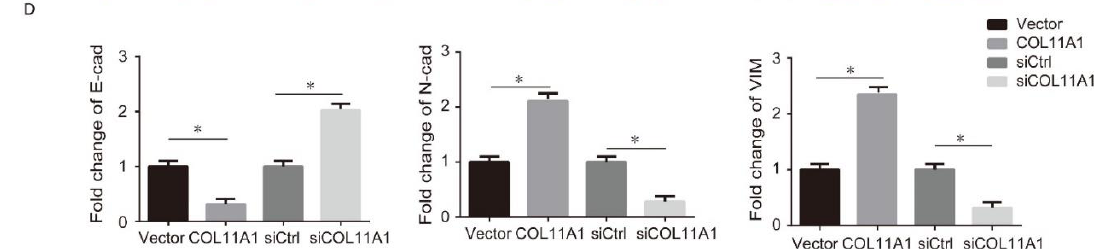
Figure 2. COL11A1 modulated the expression levels of epithelial-mesenchymal transition (EMT) markers and matrix metalloproteinase (MMP)-2/9: ( A ) expression levels of EMT markers and MMP- 2/9 were detected by Western blotting analysis in BxPC-3, Capan-2, and PANC-1 cells transfected with siCOL11A1 or pCMV3-COL11A1; ( B ) protein levels of EMT markers and MMP-2/9 were normalized to those of β -actin in PANC-1, BxPC-3, and Capan-2 cells after the indicated treatment; ( C ) expression levels of EMT markers were examined by confocal microscopy in PANC-1 cells transfected with pCMV3-COL11A1 or siCOL11A1 ( × 100); ( D ) expression levels of N-cadherin (N-cad), E-cadherin (E-cad), and vimentin (VIM) were calculated as a ratio compared with the controls ( n = 3, * p < 0.05).